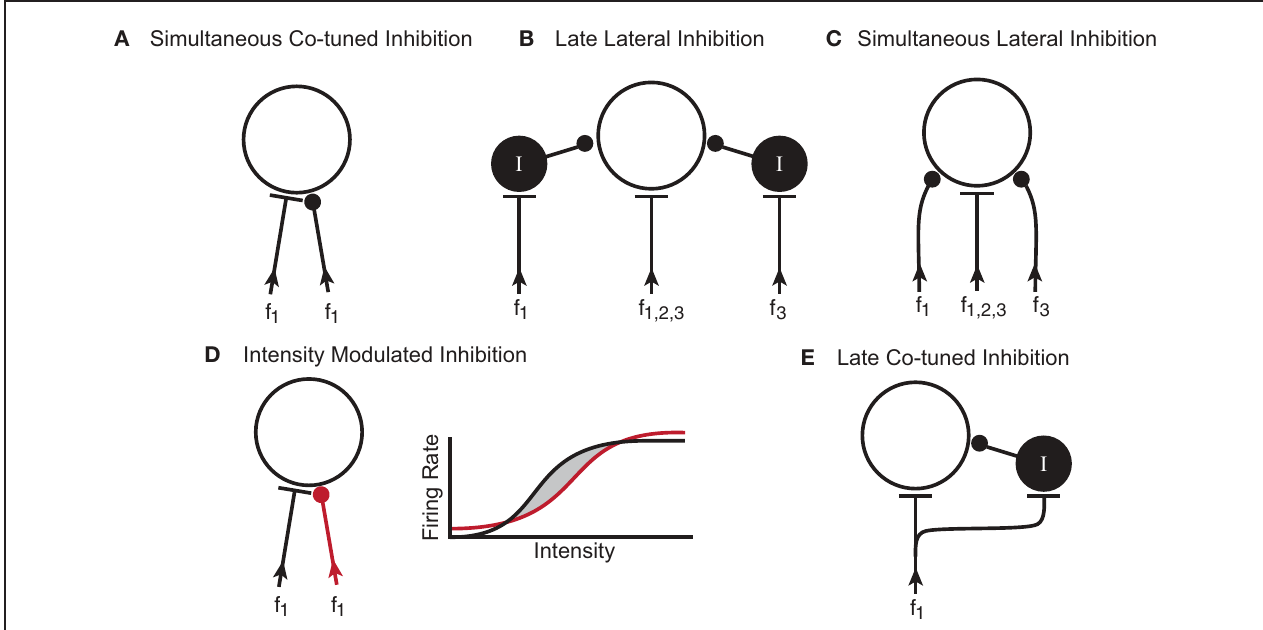
FIGURE 9 | Potential microcircuits that could shape responses to simple and complex stimuli in the IC. (A) Simultaneous co-tuned inhibition. The excitatory and inhibitory inputs have similar frequency tuning and arrival time at the IC neuron. (B) Late lateral inhibition. Lateral inhibition results from inhibitory interneurons (I) with frequency ranges that are lateral (f1 and f3) to the excitatory input (f1,2,3). Synapsing onto an interneuron could delay the arrival time of the inhibition relative to the excitatory input. (C) Simultaneous lateral inhibition. Lateral inhibition results from direct inhibitory inputs (f1 and f3). (D) Intensity modulated inhibition. Excitatory (black) and inhibitory (red)